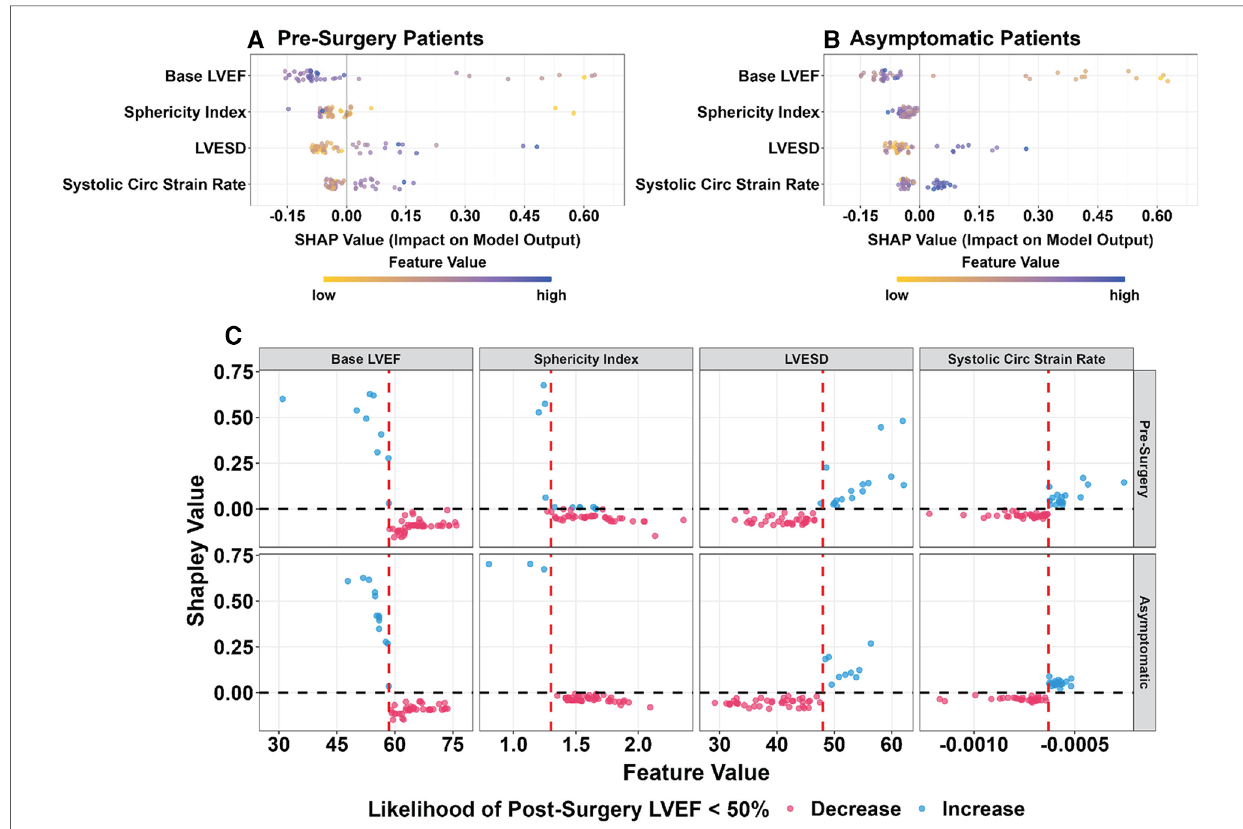
FIGURE 4 SHAP values for pre-surgery ( A ) and asymptomatic ( B ) PMR patients. Color value of each feature: highest blue and lowest yellow. Negative SHAP value (left side of 0.0) is a negative impact on the odds ratio, i.e., less likely to have post-surgical LVEF<50%. Positive SHAP value (right side of 0.0) indicates a higher probability of post-surgical LVEF<50%. ( C ) SHAP values for pre-surgery (top) & asymptomatic (bottom) PMR presented with potential cutoff values (red vertical dashed line) indicating the likelihood of post-surgical LVEF<50%. A negative SHAP value (red) indicates a negative impact on the odds ratio, i.e., less likely to have post-surgical LVEF<50%. A positive SHAP value (blue) indicates a higher probability of post-surgical LVEF<50%. Each circle is representative of an individual